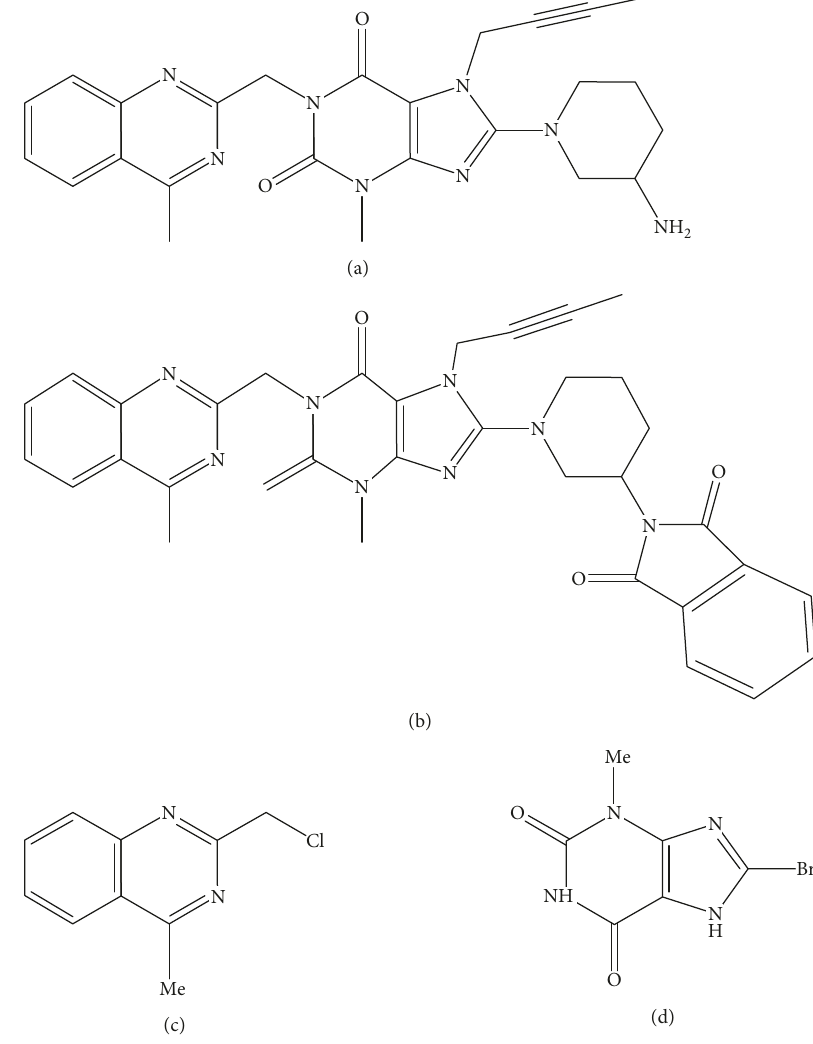
Figure 1: Chemical structures of LGT (a) and its synthetic impurities